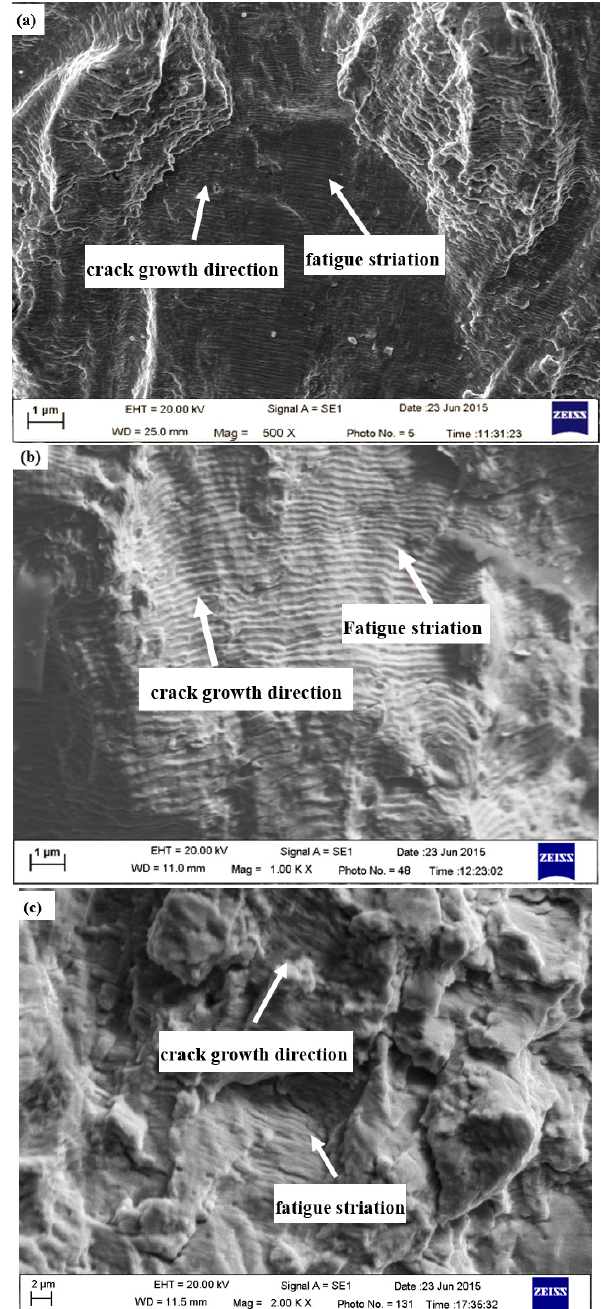
Figure 8. Fracture surface in FCG area: ( a ) the BM; ( b ) the HAZ specimen; and ( c ) the WM specimen.